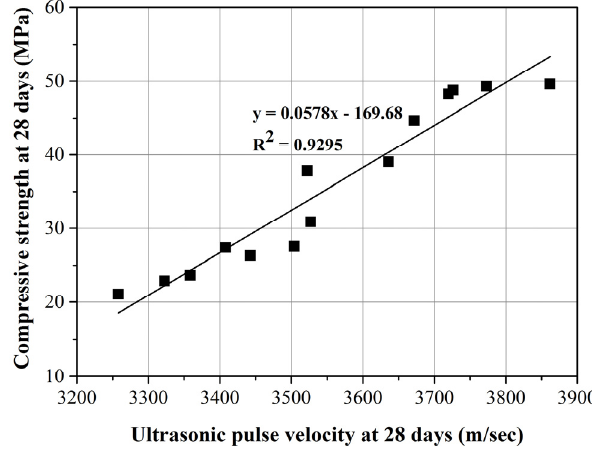
Figure 11. Correlation between compressive strength and UPV values of mortars at 28